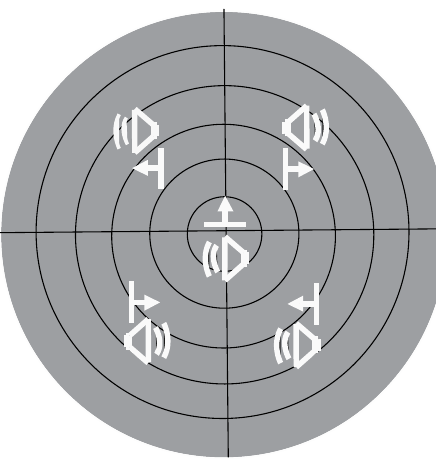
Figure 2. Cross-modal exposure sites. During exposure sessions, animals in the VA Trained group were presented with spatiotemporally concordant visual-auditory stimuli that appeared randomly at one of 5 locations as shown by the two icons (a speaker and a bar of light moved in the direction of the arrow) on a schematic of the central 60° of